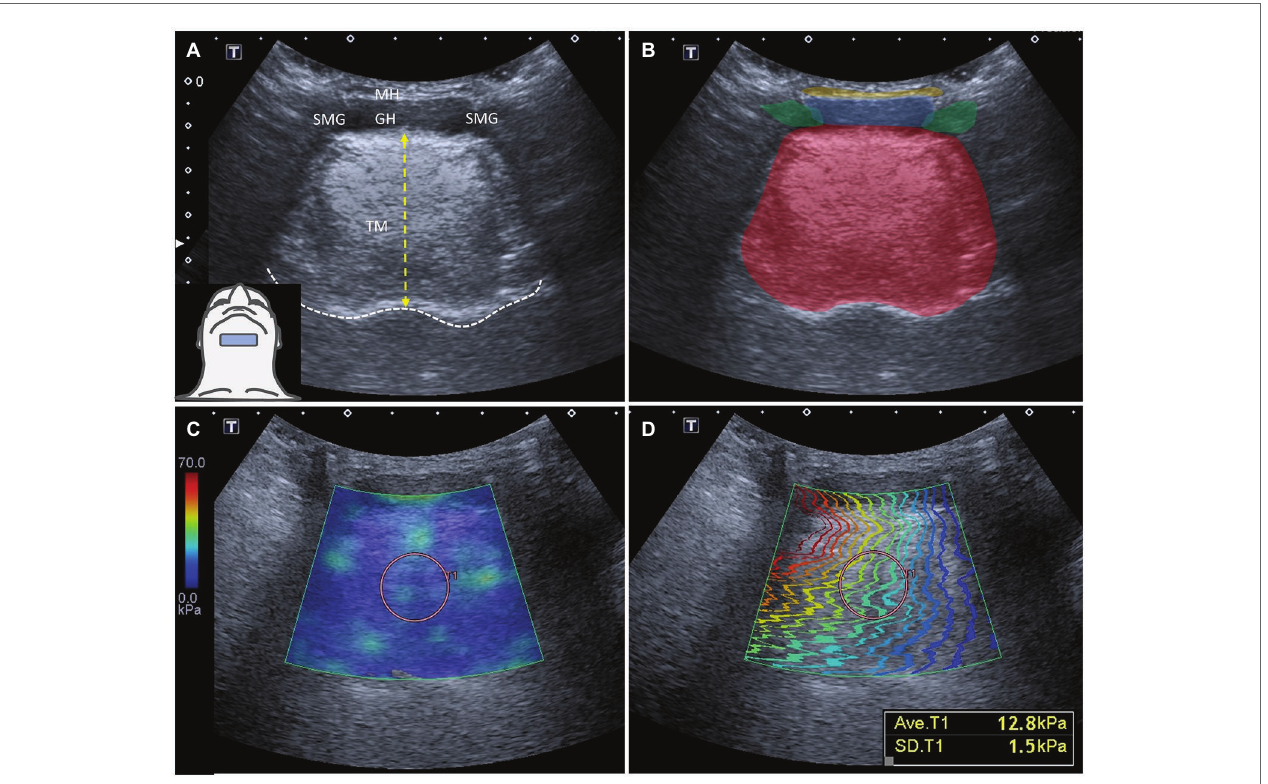
FIGURE 3 | Ultrasound imaging (A) and superimposed schematic drawing (B) of the tongue muscles in the coronal plane. The white dashed line indicates the dorsal surface of the tongue. The length of the yellow-dashed line indicates the thickness of the tongue. The color diagram (C) and propagation modes (D) of shear wave ultrasound elastography imaging for the tongue muscles in the coronal plane. The average shear modulus of the tongue in the selected region of interest is 12.8 kPa with a standard deviation of 1.5 kPa. TM: tongue muscles, red color block; MH: mylohyoid muscle, yellow color block; GH: geniohyoid muscle, blue color block; and SMG: submandibular gland, green color block.